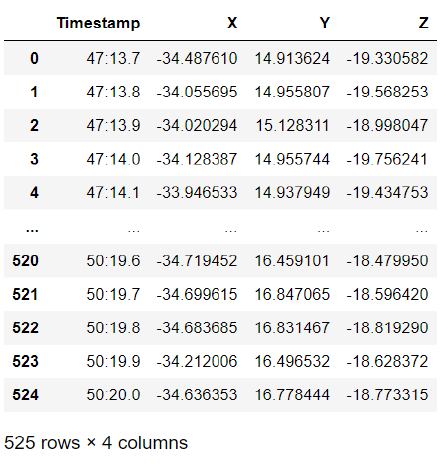
Figure 59. Merged magnetic data ( x,y,z ).